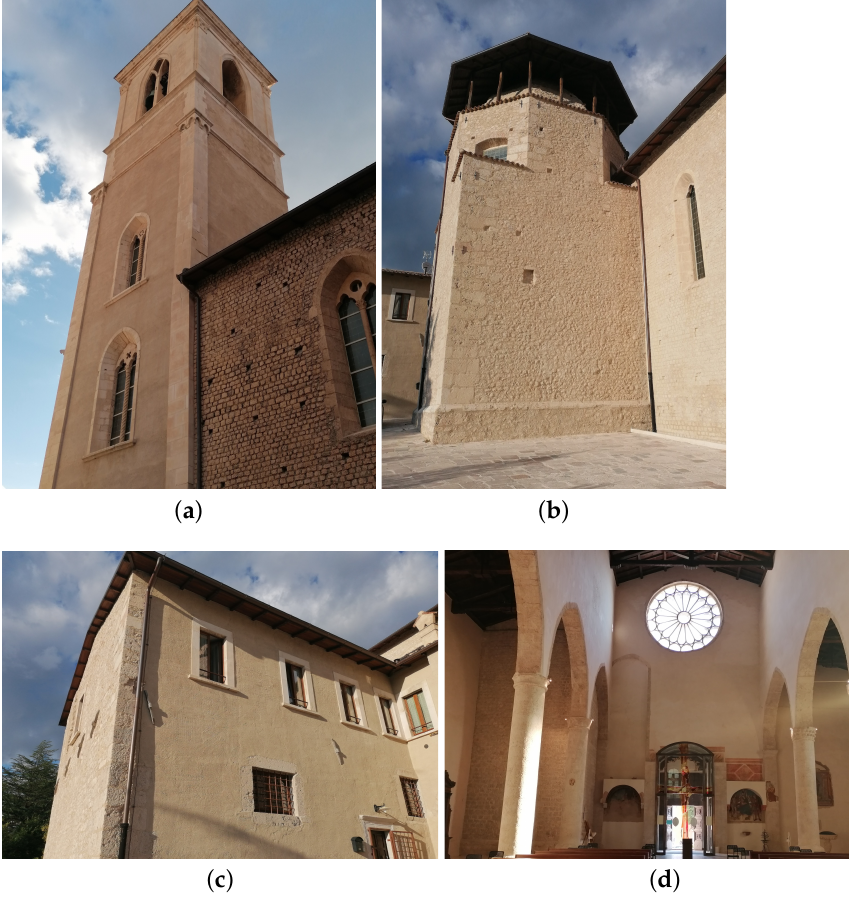
Figure 4. The St.Silvestro complex after the rehabilitation works following the 2009 earthquake: